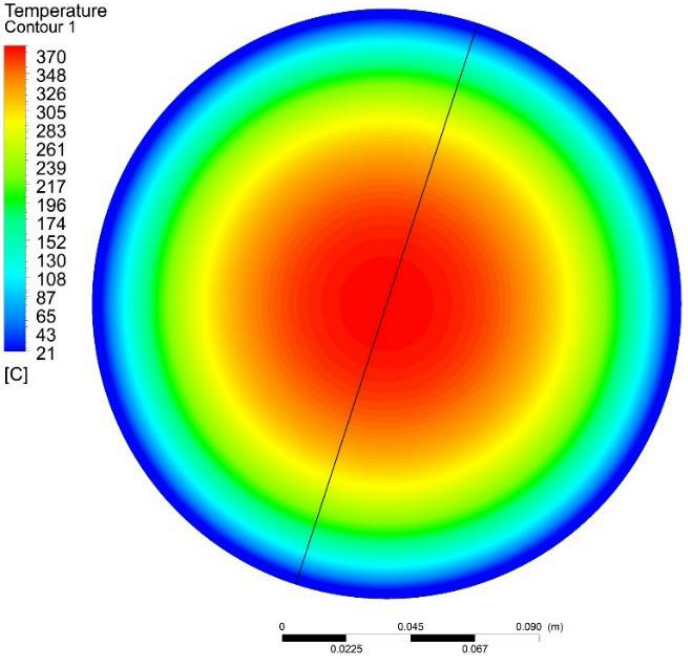
Figure 5. Thermal field in Geometry 1 at 1200 s without a heat transfer intensifier. The black line in Figure 5 represents the line along which the temperature changes were measured in the radial direction. An 18 ◦ angle between the line and the vertical direction was selected, to ensure that in the other geometries (2, 3 and 4), it would cross the centre between the primary and secondary fins. Figure 6 shows the curves of the temperature changes in the radial direction at the times of 300, 600, 900, and 1200 s.